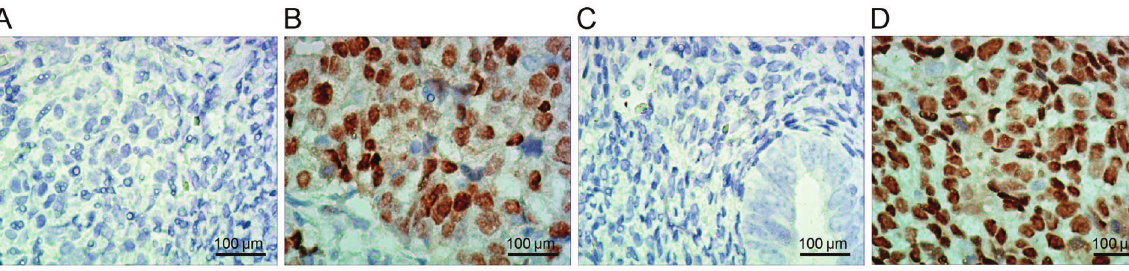
Figure 1. Protein expression of ezrin and galectin-3 in each group. A, Negative ezrin protein expression in cervicitis tissue; B, Positive ezrin protein expression in cervical cancer group; C, Negative galectin-3 protein expression in cervicitis group; D, Positive galectin-3 protein expression in cervical cancer group.